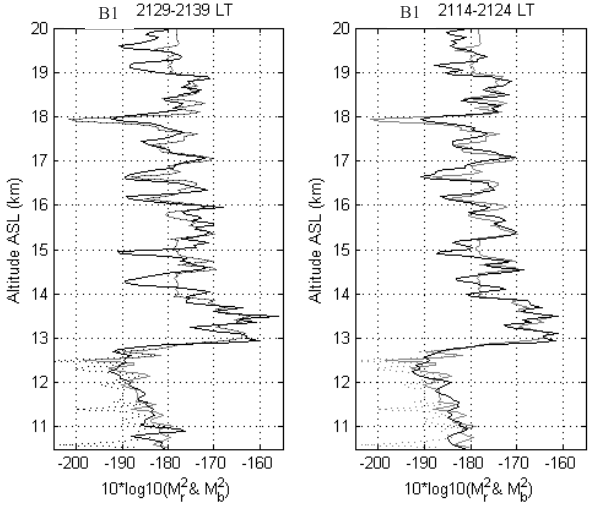
Fig. 11. (Left) Same as Fig. 4a after a 10-min averaging between 21:29 and 21:39 LT during the balloon flight. (Right) Same as left after a 10-min averaging between 21:14–21:24 LT in order to take into account the advection of the air parcels by the